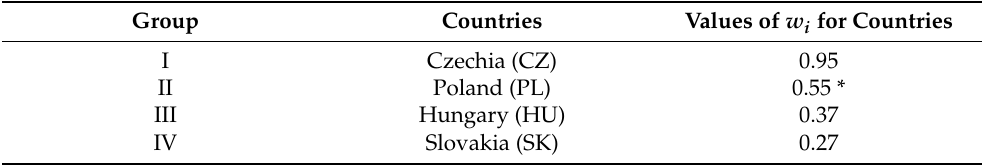
Table 4. Groups of the V4 countries based on the main energy producers’